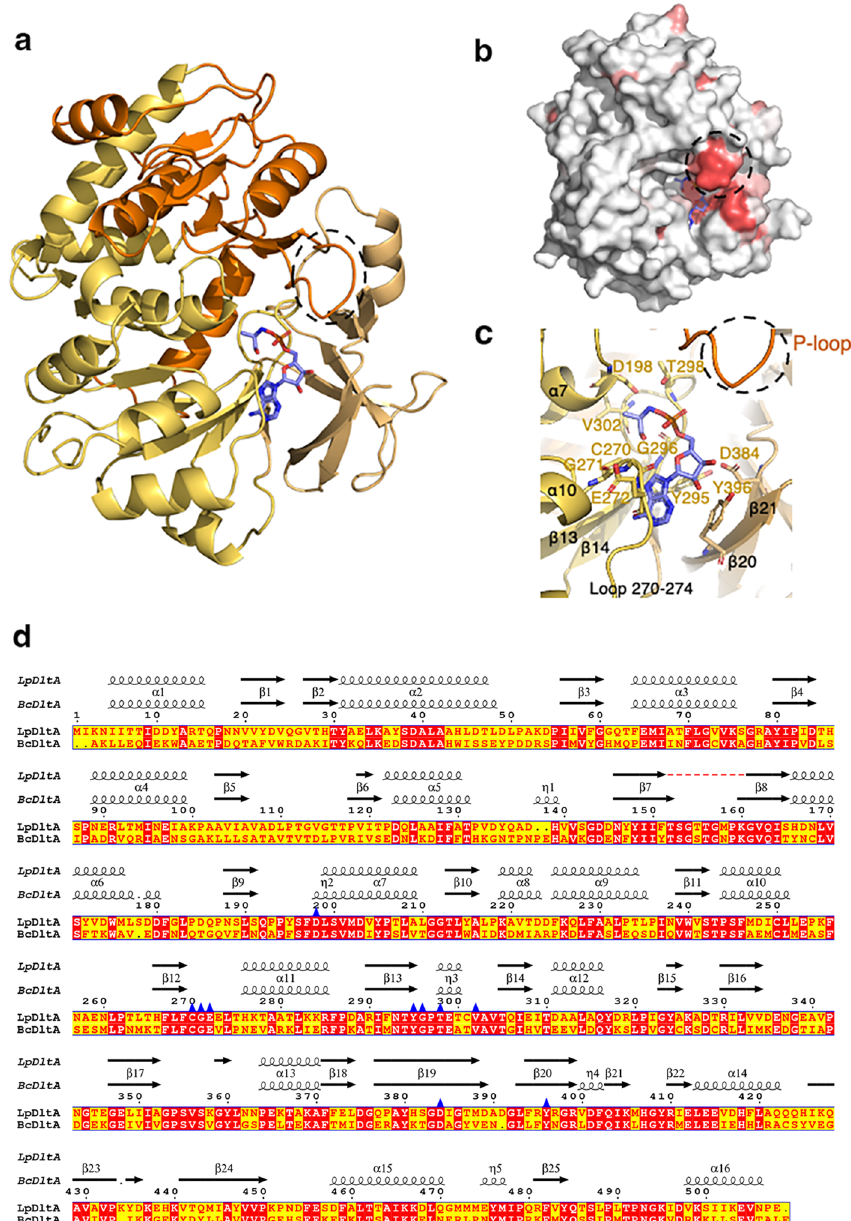
Figure 3. The L. plantarum DltA structure. ( a ) Cartoon representation of the N-terminal domain of DltA structure. The subdomains A (3–48, 188–320), B (49–187) and C (321–400) are respectively colored in orange, yellow and wheat. The d-Ala-AMP substrate is shown as blue stick. The P-loop is encircled with dashed black line. ( b ) Surface representation of the N-terminal domain of DltA colored according to sequence conservation. The color ramping from white (low score) to red (identity) locate areas of weak and strong sequence conservation. The figure was generated with ENDscript (https:// endsc ript. ibcp. fr/) ( c ) Close-up on the substrate binding site of DltA, the d-Ala-AMP (in blue) and the residues involved in the interaction are shown as sticks ( d ) Sequence alignment between L. plantarum DltA (LpDltA) and DltA from B. cereus (BcDltA—PDB entry 3DHV). The secondary structures extracted from the X-ray structures are depicted above. The position of the LpDltA residues interacting with the d-Ala-AMP substrate are highlighted by a blue triangle. The position of the P-loop is shown with a dashed black line. The figure was generated by ESPript (https:// espri pt. ibcp.